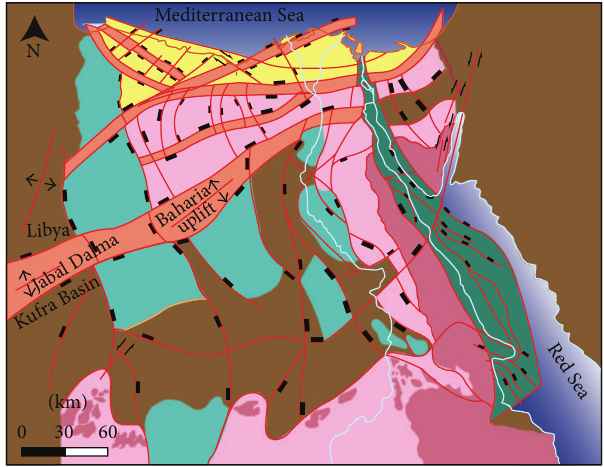
Figure 3: Basement structure map of Egypt (modified from [2]).